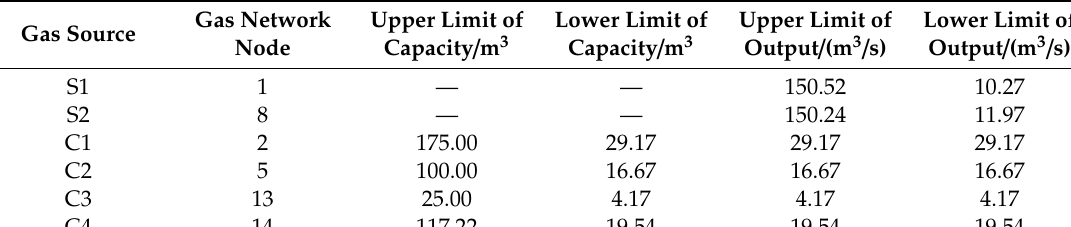
Table A3. Parameters of sources.